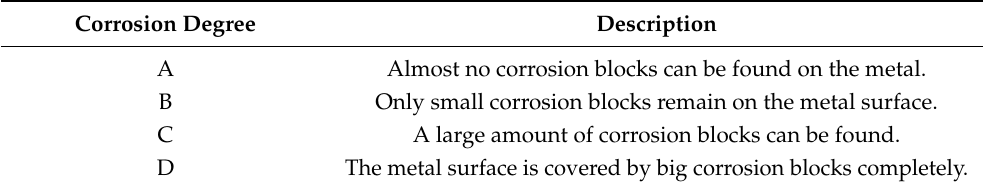
Table 1. The description of corrosion